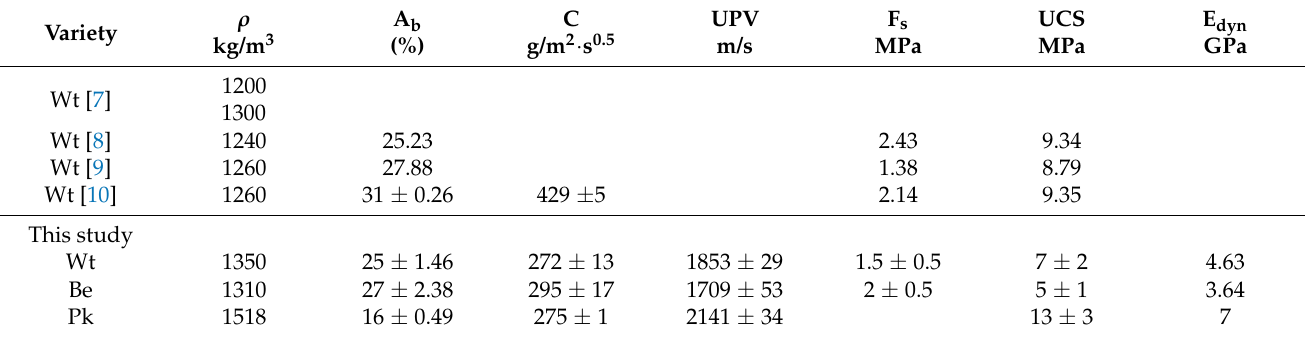
Table 3. Comparison of results of Arequipa ignimbrites